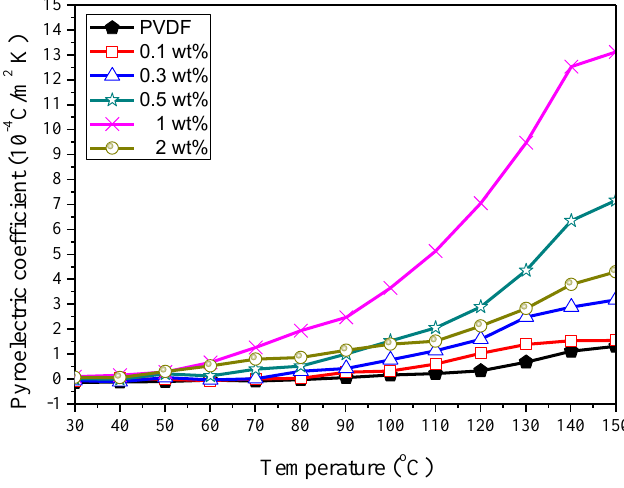
Figure 15. The pyroelectricities of 10 wt% PVDF film with different wt% GO-doping (0.0, 0.1, 0.3, 0.5, 1.0, and 2.0).